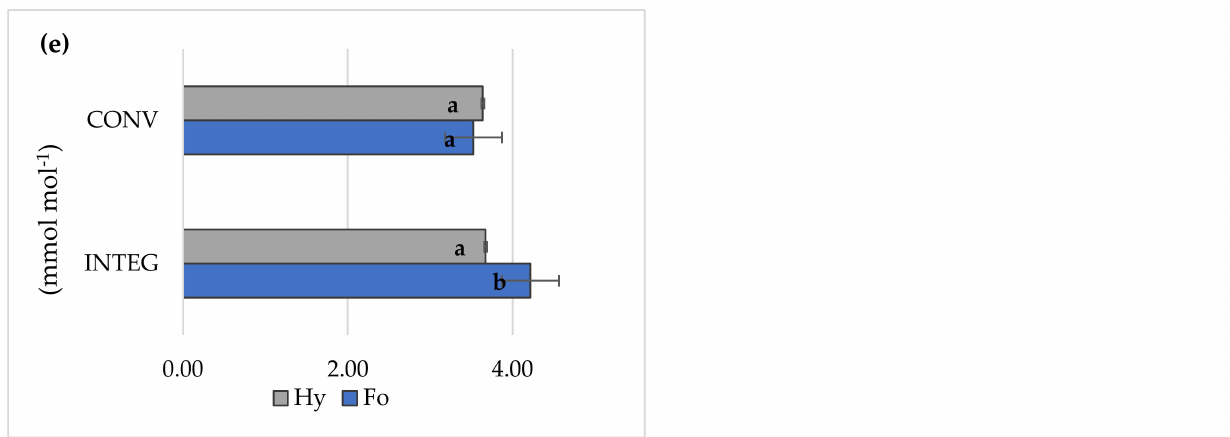
Figure 6. ( a – e ) Selected gas exchange parameters depending on cultivars and cropping systems. ( a ) P N —net photosynthetic rate, ( b ) gs—stomatal conductance, ( c ) E—transpiration rate, ( d ) Ci— intracellular CO 2 concentration, and ( e ) WUE—water use efficiency. The presence of different lower- case letters indicates a statistical difference between means (Tukey’s Test, p = 0.05). INTEG—integrated